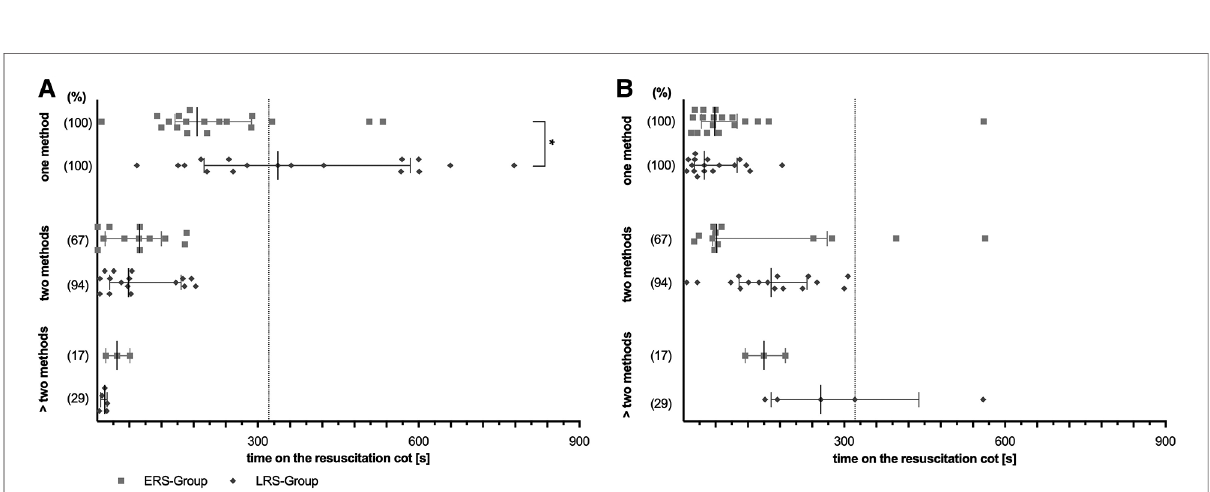
FIGURE 4 Concomitant stimulations. Overall duration ( A ) and fi rst time ( B ). Scatter dot plot for only one stimulation method up to more than two applicated concomitant stimulation methods. Two subgroups are depicted: LRS, late respiratory stability group; ERS, early respiratory stability group. (%) – proportion of stimulated infants within the particular group; p -values - * p =0.015; * p